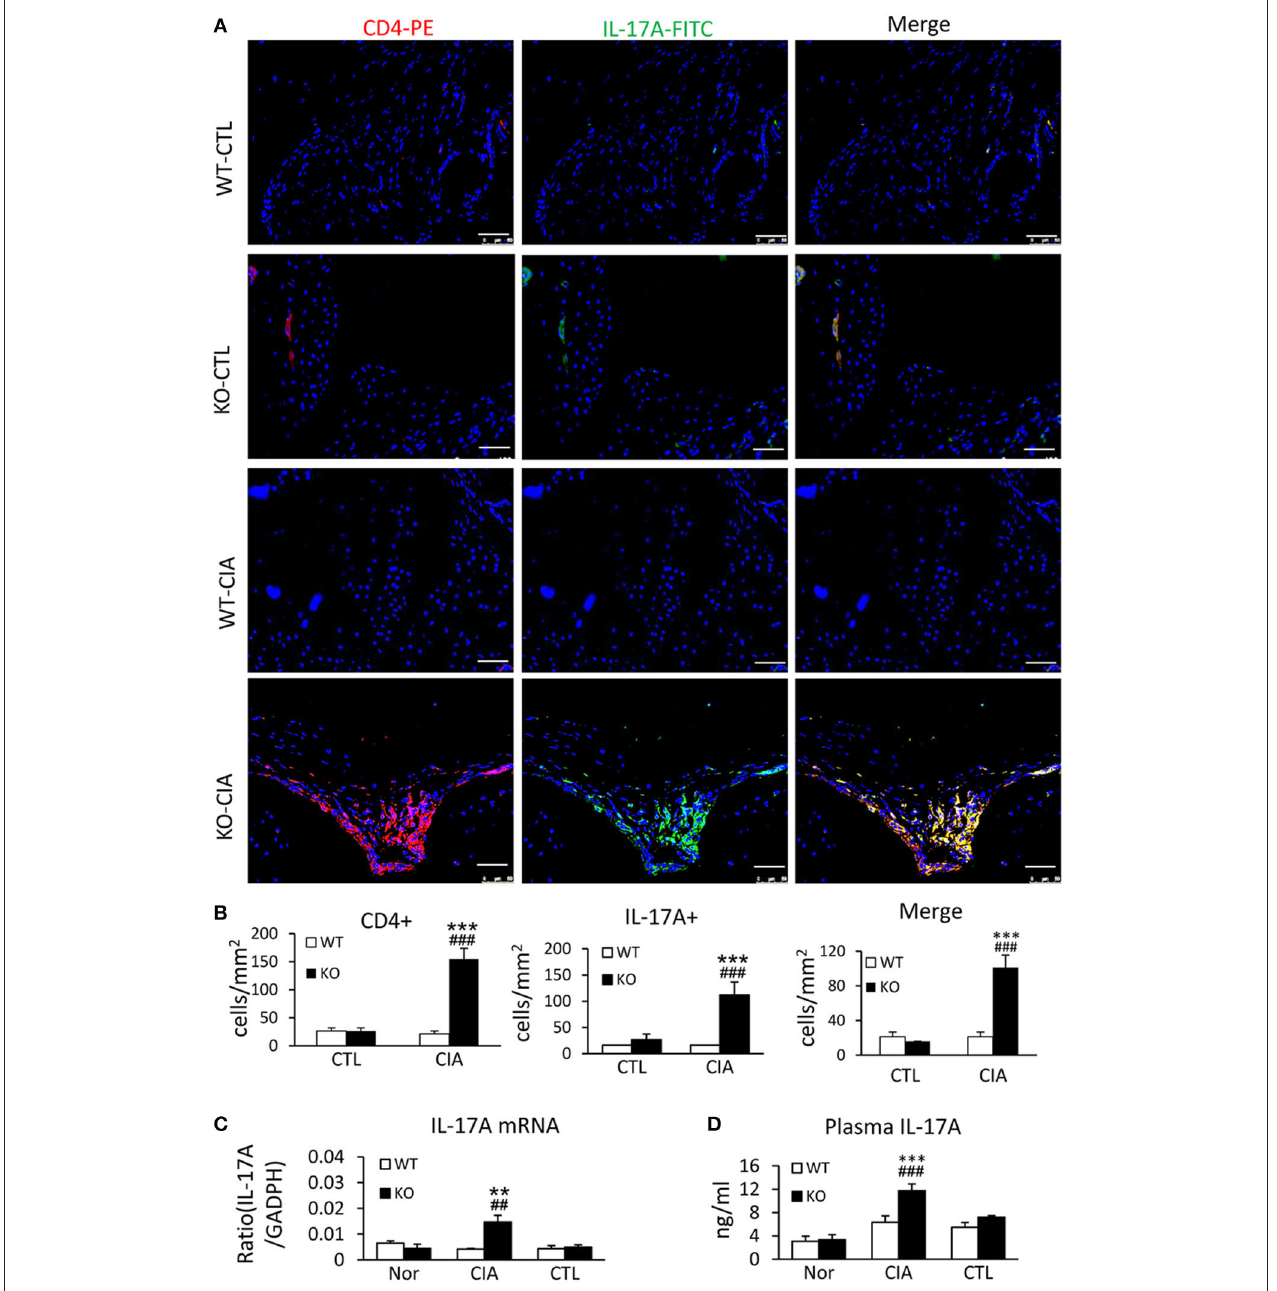
FIGURE 5 | Smad7 deficiency largely enhances the Th17 response both systemically and locally in the synovial tissues of CIA in CD-1 mice. (A) Two-color immunofluorescence for detection of CD4 + IL-17A + cells in the synovial tissues. (B) Quantitative analysis of CD4 + , IL-17A + , and CD4 + IL-17A + cells. (C) Real-time PCR analysis of IL-17A mRNA expression. (D) ELISA analysis of serum levels of IL-17A. Results show a marked Th17 response developed in Smad7-KO but not in Smad7-WT mice both systemically and locally in the joint tissues after disease induction at week 10. Data are expressed as mean ± S.E. for group of 8 mice. ** p < 0.01, *** p < 0.001 vs. control group; ## p < 0.01, ### p < 0.001 vs. WT-CIA group. Scale bar, 50 µ